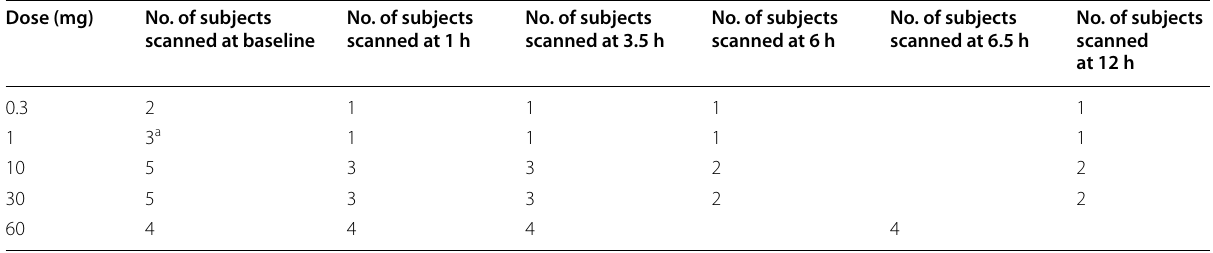
Table 1 Numbers of subjects in each dose group and PET scan time points after oral dosing with the α antagonist